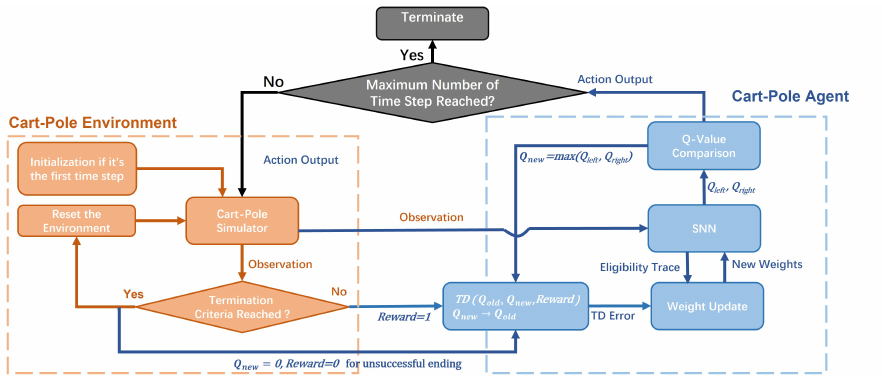
Figure 1. A general workflow of the training process using